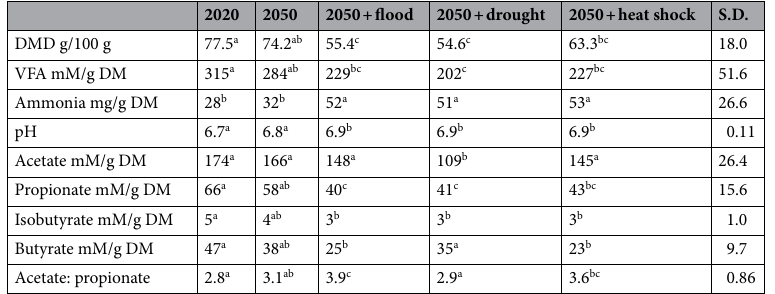
Table 4. Fermentation profile values for VFA, ammonia and pH end point analysis. Lower case letters indicate significant difference based on ls means with Tukey adjustment ( P < 0.05).